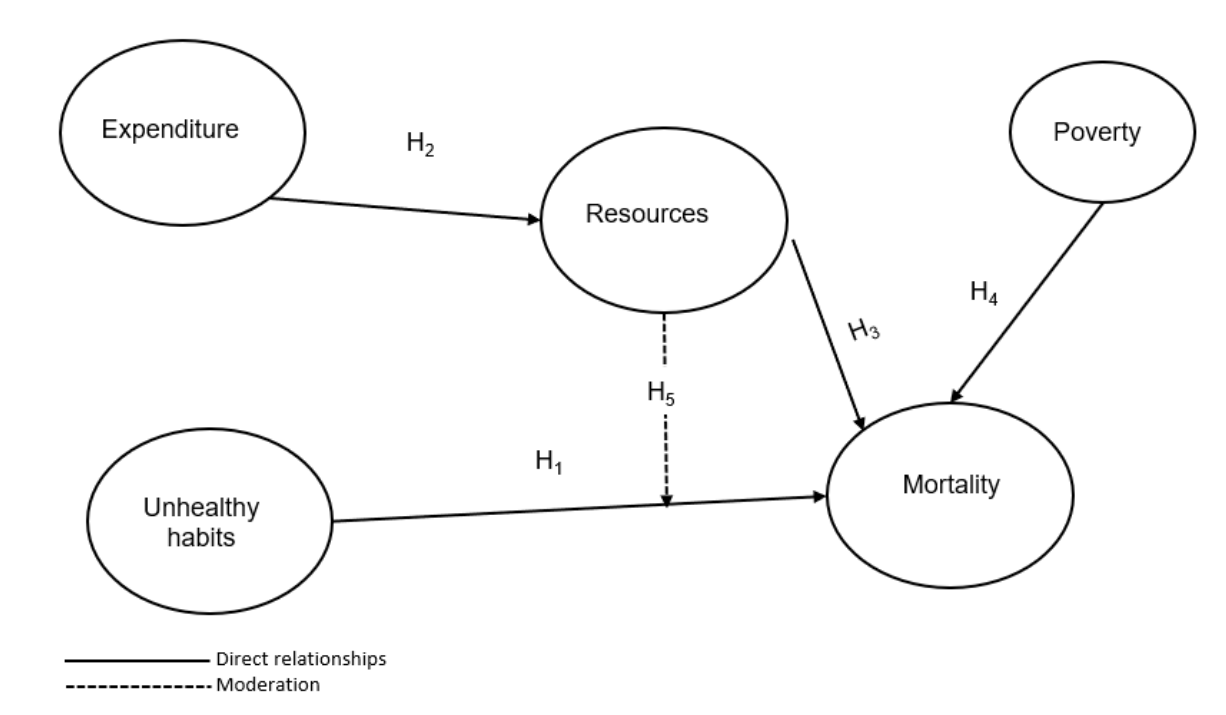
Figure 4. Conceptual model of the study.